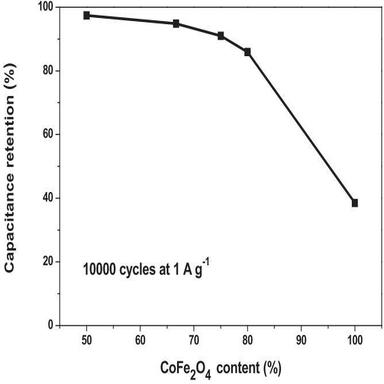
The capacitance retention of CDC/CoFe2O4 composites versus CoFe2O4 content in composites.